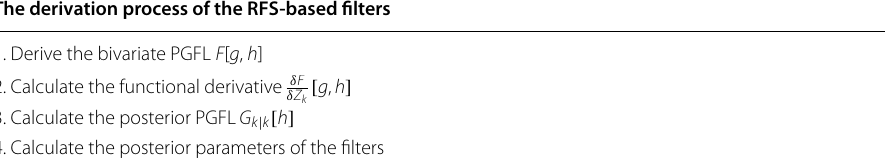
Table 1 Algorithm 1 The derivation process of the RFS‑based